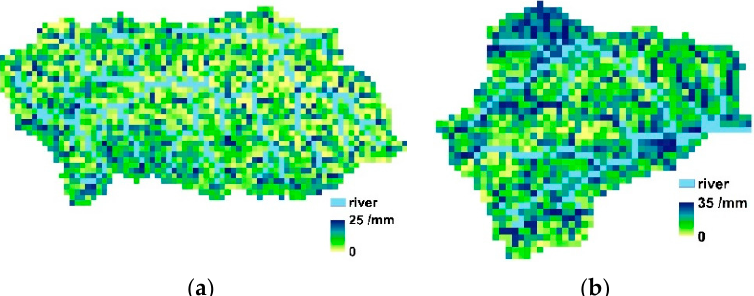
Figure 3. Spatial distribution of free water storage capacity, estimated from the topographic index for ( a ) the Chenhe Watershed and ( b ) the Changhua Watershed.